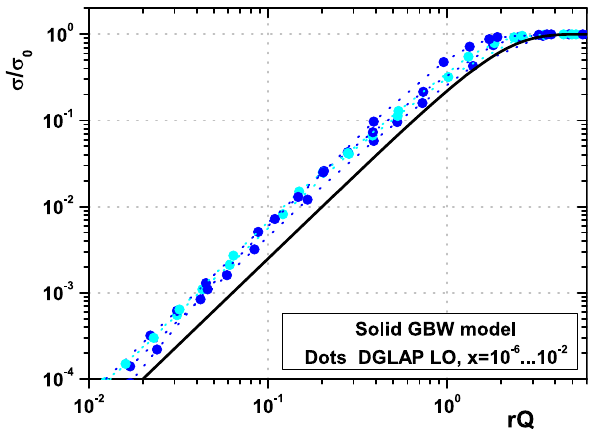
Fig. 6 The same as Fig. 4 within the NLO approximation